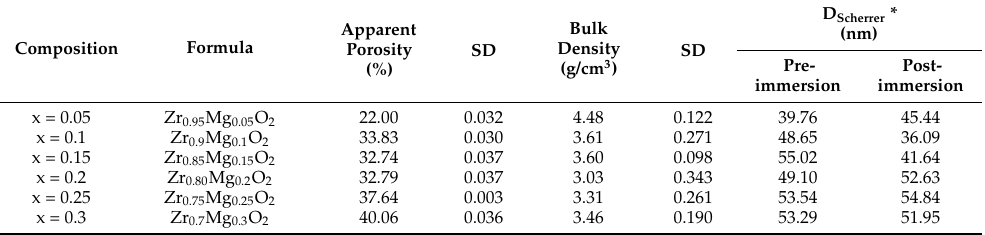
Table 1. The prepared compositions of the Zr 1 − x Mg x O 2 system, samples formula, bulk density, apparent porosity, standard deviation (SD) and crystallite size pre- and